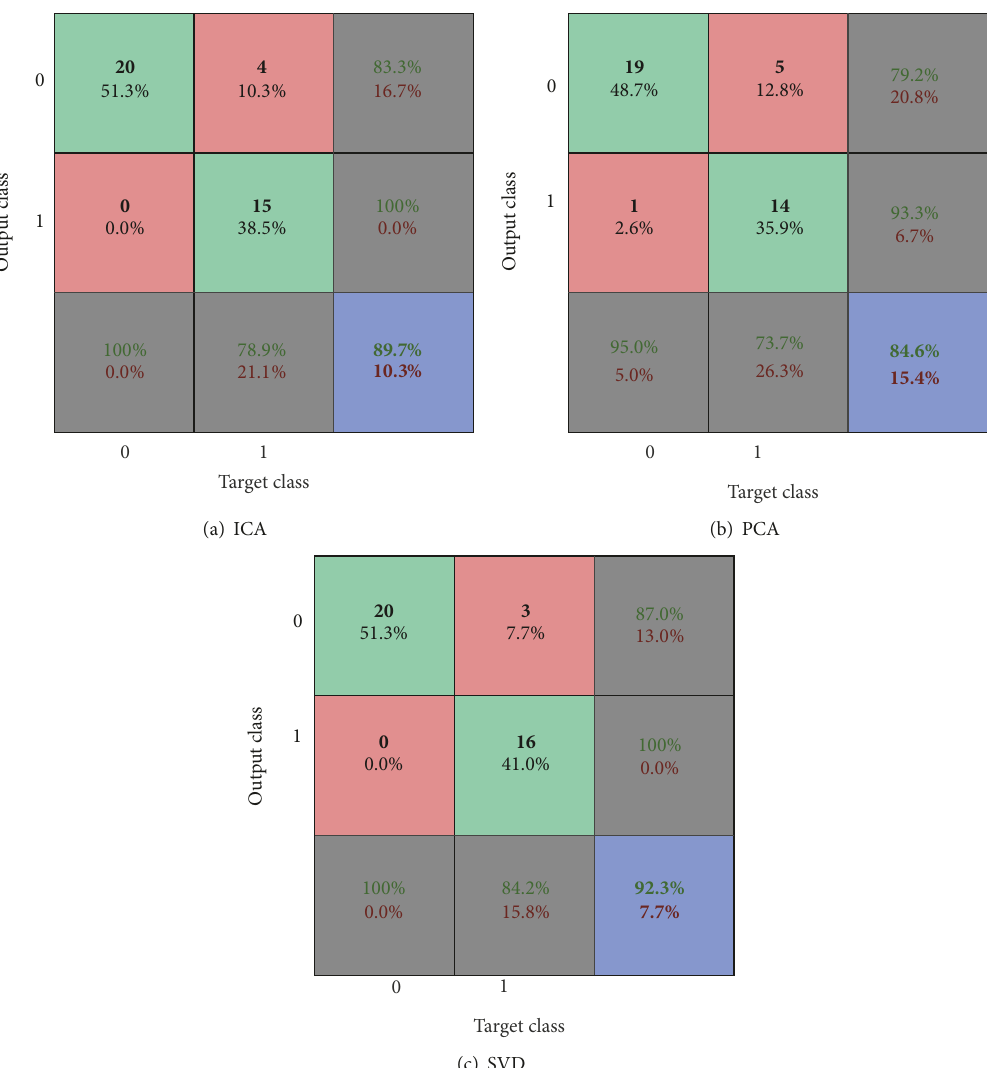
Decision boundaries are not always clear-cut. In fact, they are the transition from one class in the feature space to another, which is not discontinuous, but gradual. In this plot, red color was chosen to demonstrate the highest probability and blue color represents the lowest probability as well. The black scatter points are the samples predicted by the classifier for each class. It can be seen that it is less probable to predict a subject in the surface area with blue